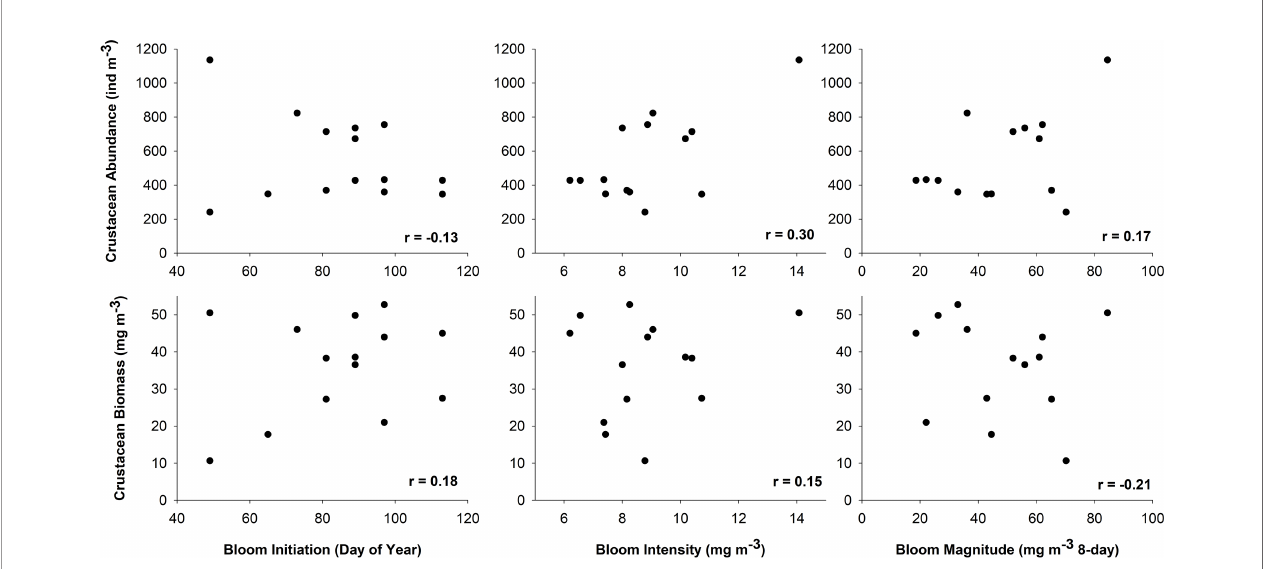
FIGURE 7 | Relationships between annual abundance (top panels) and biomass (bottom panels) of crustacean zooplankton and bloom phenology dynamics from 2003-2016 in the Strait of Georgia,